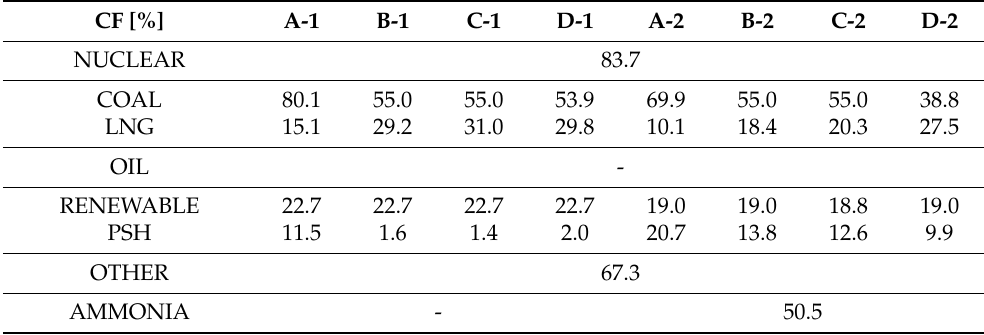
Table 7. Average capacity factor of